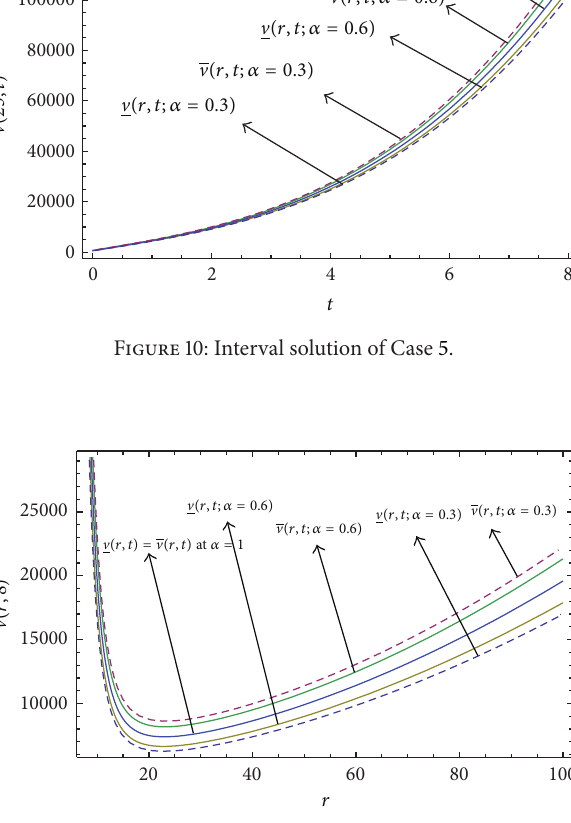
Figure 11: Interval solution of Case 1 at 𝑡 = 8 .